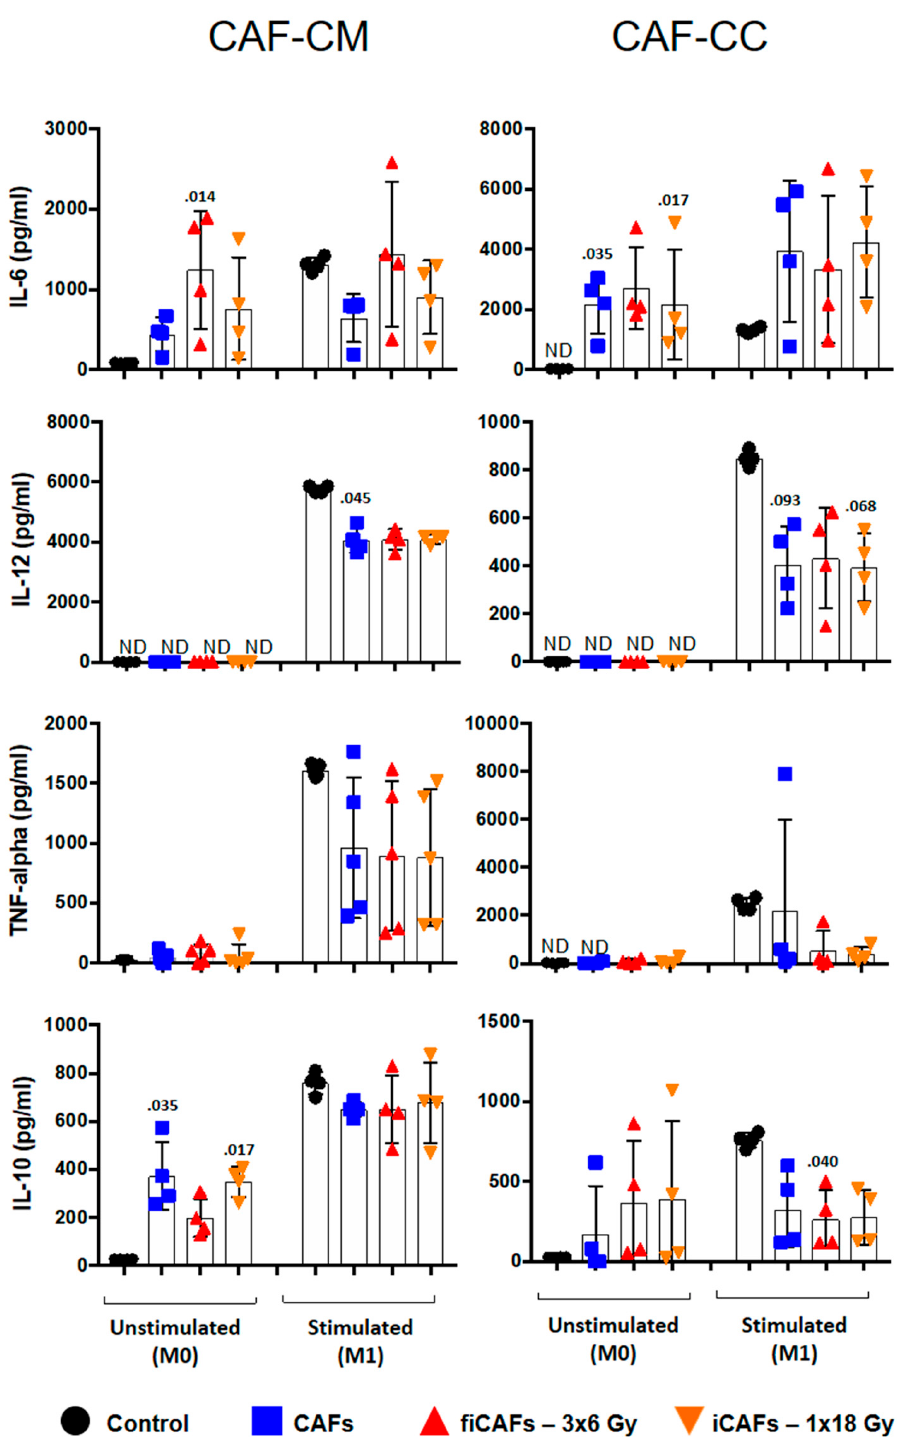
Figure 4. CAF-induced cytokine secretion by macrophages. Monocyte-derived macrophages in non-stimulated or stimulated conditions were incubated with irradiated or non-irradiated CAFs conditioned medium (CM) or in (CAF-macrophage) co-cultures (CC). Resulting levels of cytokines secreted by macrophages were quantified by ELISA assay. Data represent the mean (± SD) values from four different CAF donors measured in duplicates. CAF-derived IL-6 was subtracted from full measurements. Non-parametric Kruskal-Wallis test and p -values were determined between control and non-irradiated CAF-CM, control vs iCAF-CM or fiCAF-CM.